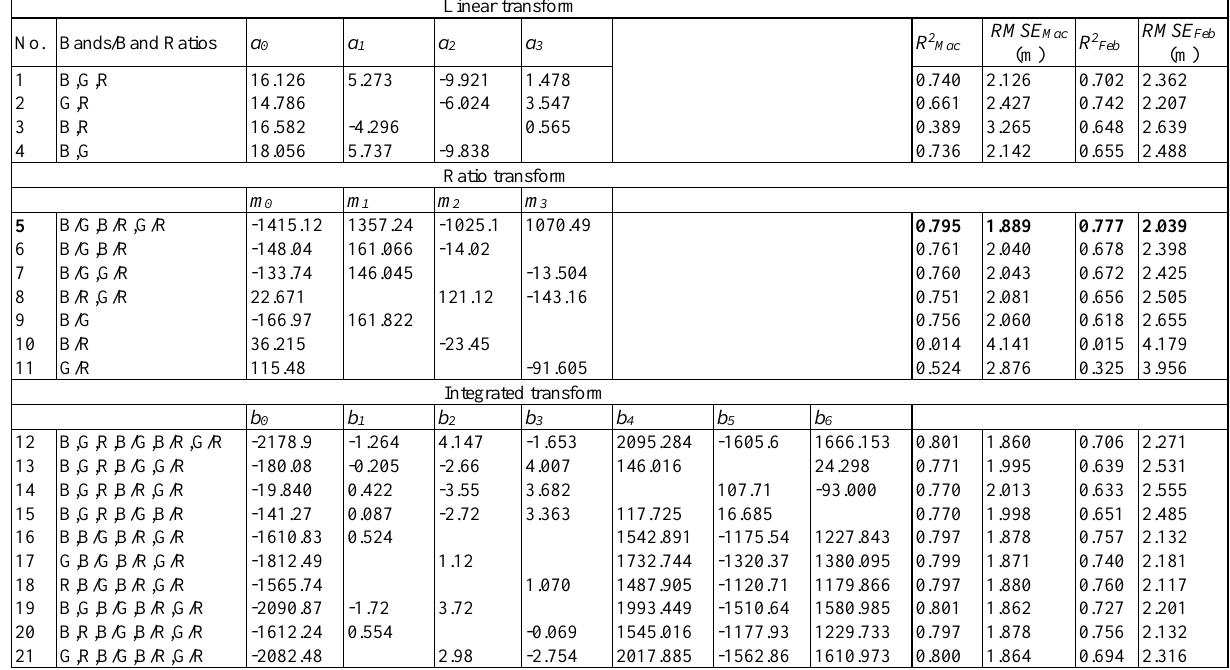
Table 2. Determined parameters for all combinations of bands/band ratios for linear, ratio, and integrated transform